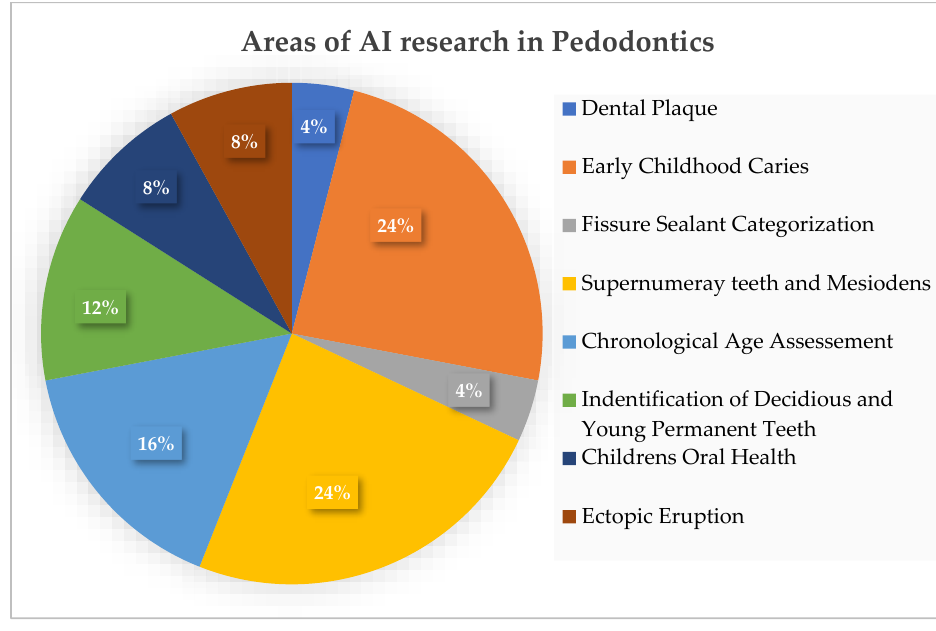
Figure 3. Areas of AI research in Pedodontics .